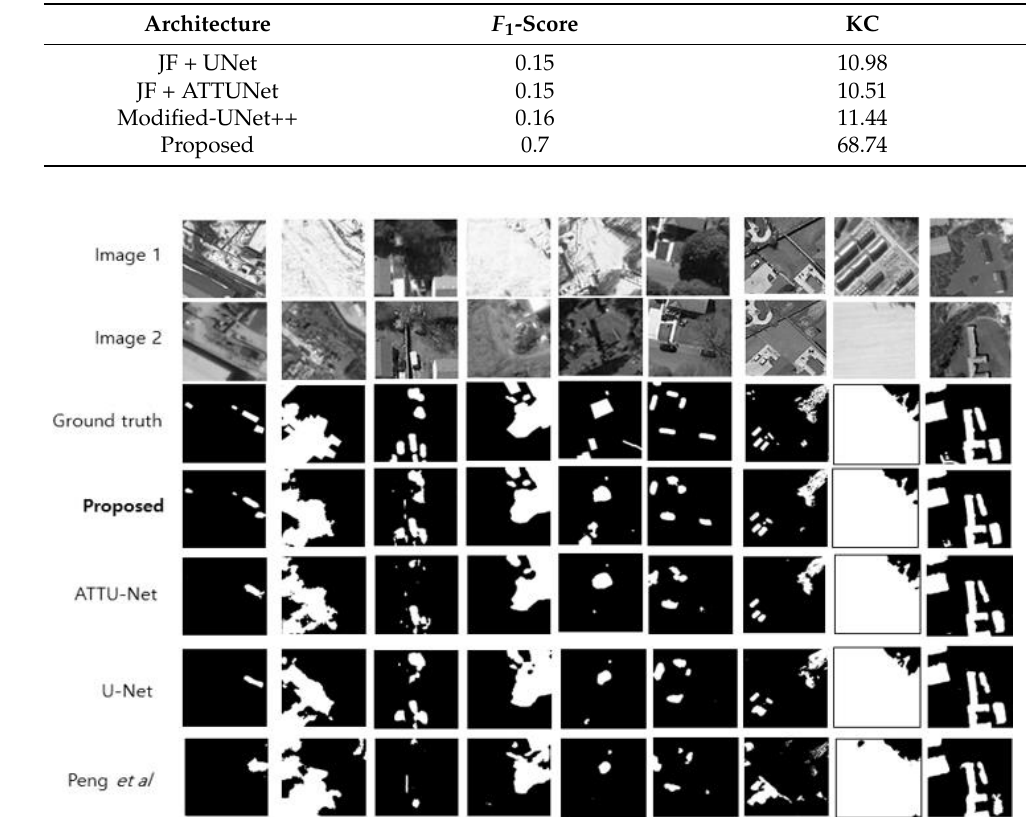
Figure 20. Subjective evaluation of the proposed and conventional algorithms for CDD dataset.